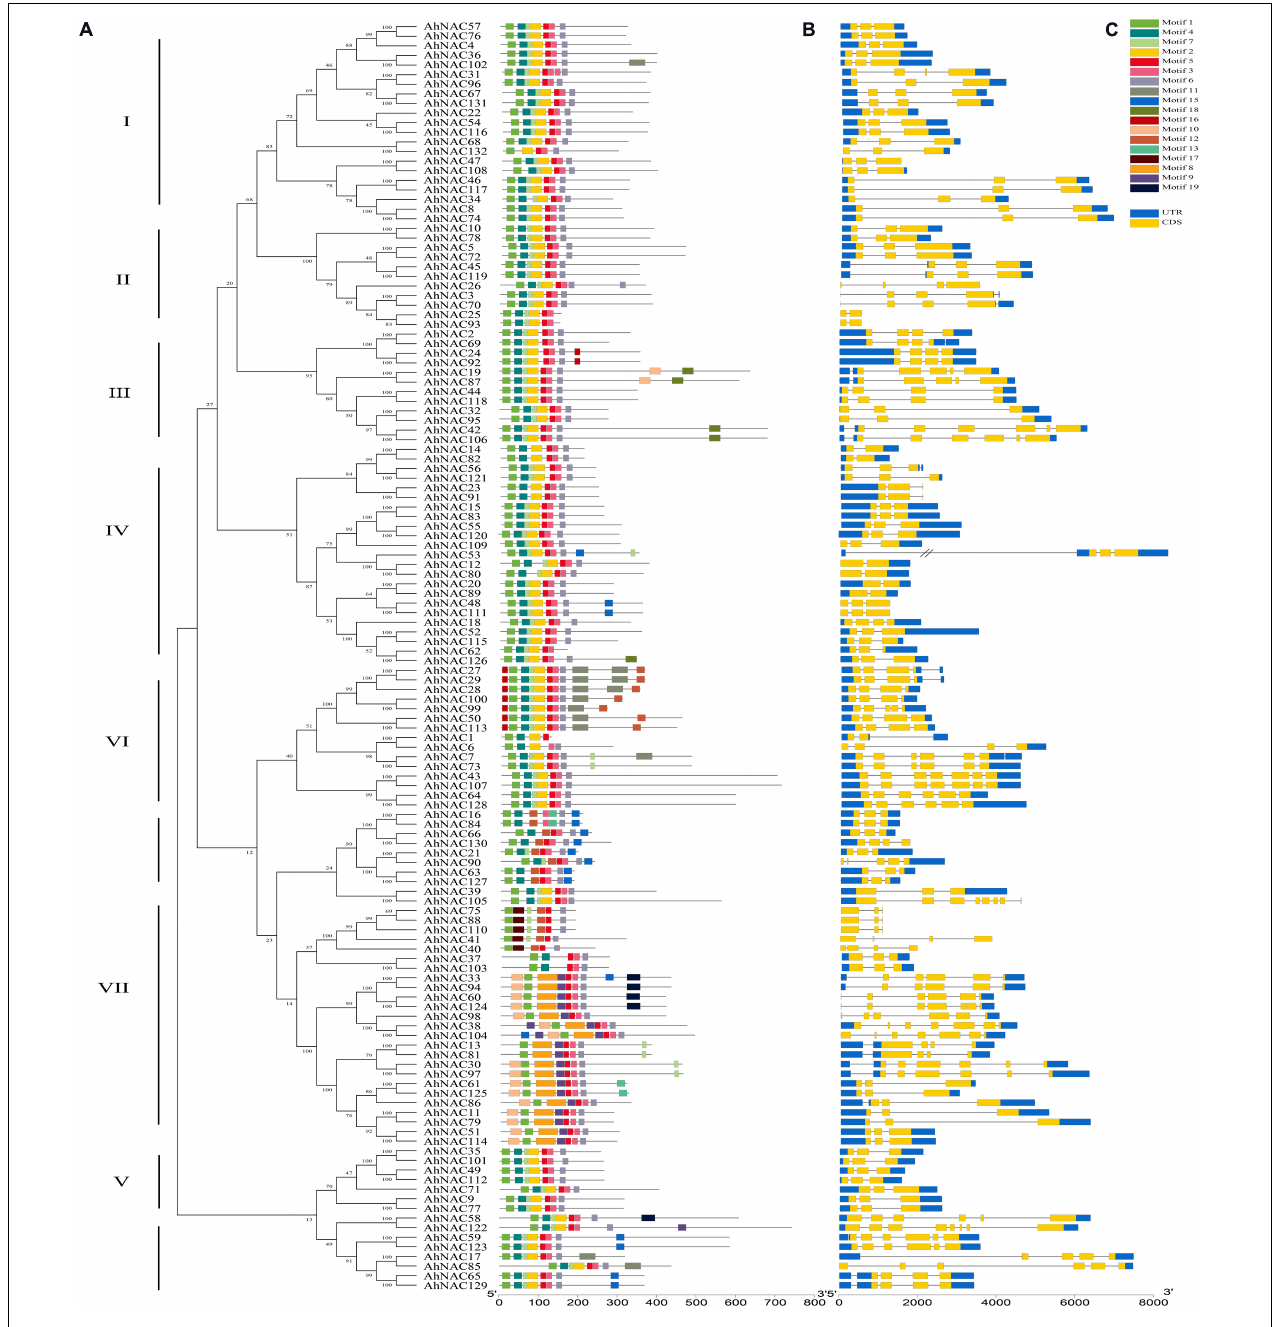
FIGURE 4 | Analysis of the conserved motifs of AhNAC family members and their coding gene structures. (A) The phylogenetic tree of peanut AhNACs was constructed in MEGA7 using the NJ method. (B) Schematic diagrams of putative conserved motifs of 132 AhNAC proteins. The conserved motifs were found using the MEME tool and are shown by different colored boxes. (C) Sketch map of the exon–intron structures of 132 AhNAC genes. The blue and yellow boxes indicate the regions of the 5 (cid:48) - and 3 (cid:48) -UTRs and the exons, respectively, and the black lines indicate the introns in